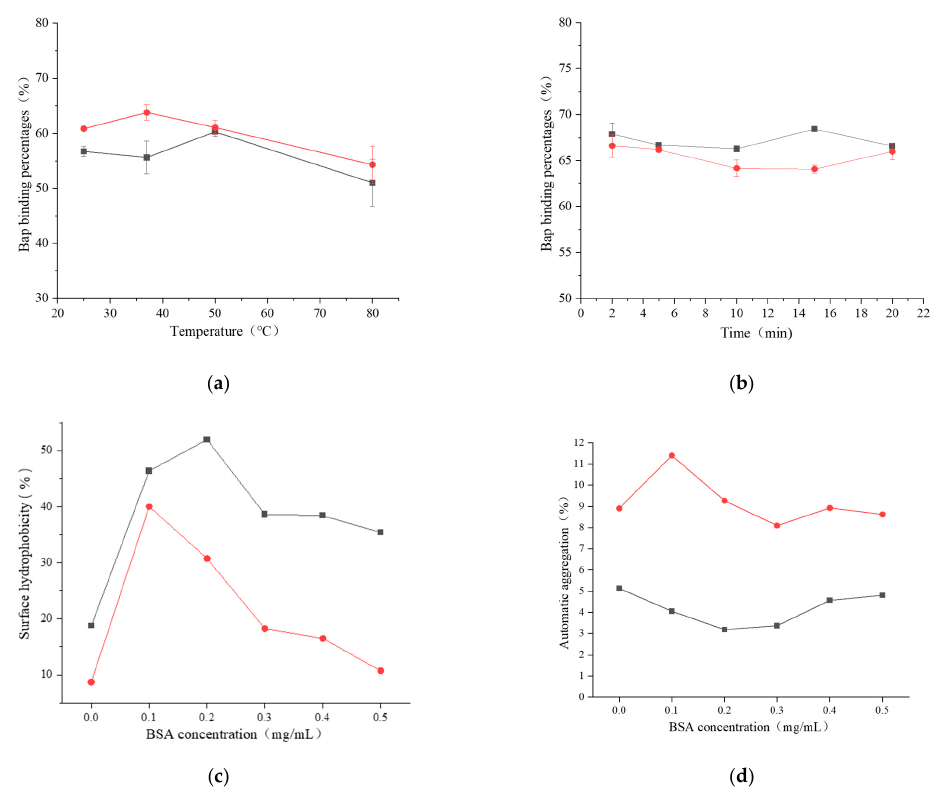
Figure 3. The effect of heat- ( a ) and ultrasonically ( b ) treated BSA on the binding of Lactobacillus –BSA to BaP. The effect of BSA on surface hydrophobicity ( c ) and automatic aggregation ( d ) of strains. Figure 1. The BaP-binding ability of Lactobacillus –BSA. Control, 121, and ML32.